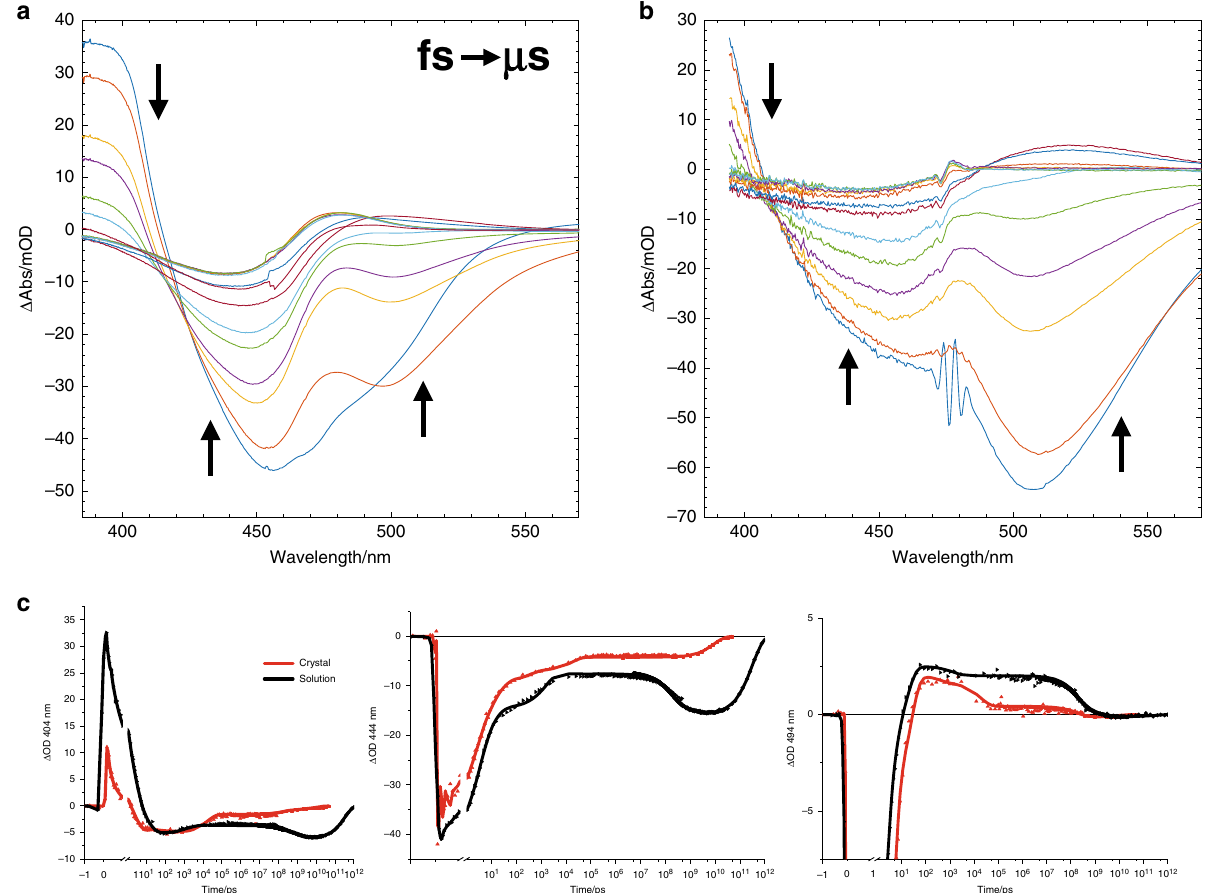
Fig. 1 Transient absorption data in the visible collected over 12 decades in time. A selection of transient absorption spectra as a function of time delay are shown, upon excitation with a 50-fs laser pulse centered at 475 nm, for a PYP S and b PYP C . The temporal evolution is indicated by the black arrows. In PYP C , a scattered-light artifact is visible at the wavelength of excitation. c Wavelength traces at 404, 444 and 494 nm of PYP S (black) and PYP C (red), see Supplementary Figs. 1 and 2 for traces at additional wavelengths. The data from the current study with sub-picosecond time resolution has been merged with data taken from Yeremenko et al. 19 with microsecond time resolution, with the latest time point at 48 ms (crystal) or 1 s (solution). Wavelength is indicated in the ordinate label. Note that the time axis is linear until 1 ps (after the maximum of the instrument response function (IRF)), and logarithmic thereafter. A single scaling parameter has been used to connect the data from the experiments with sub-picosecond and microsecond time resolution. PYP S was measured at pH 8, PYP C at pH 6.5. PYP S time traces collected at pH 6 are shown in Supplementary Fig. 1 and exhibit corresponding